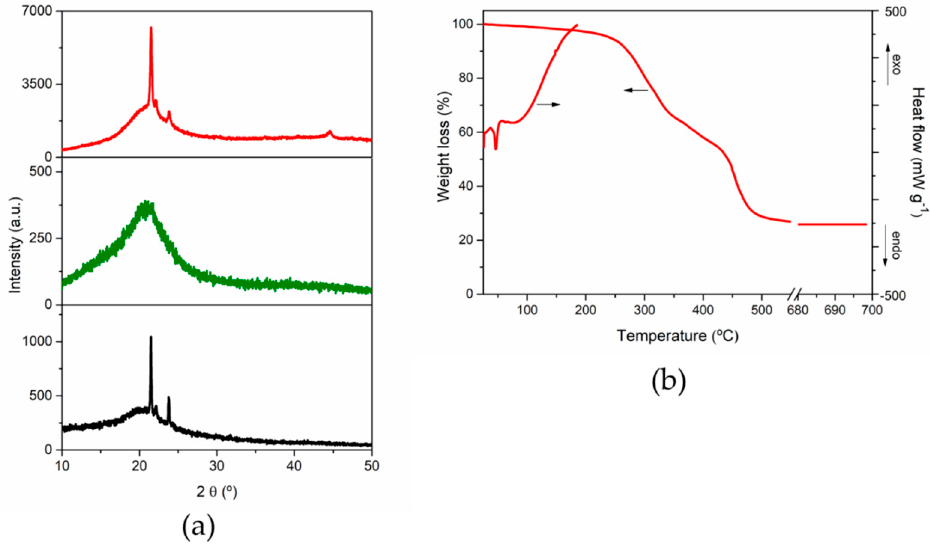
Figure 3. ( a ) Commercial PCL(530) (black line) [27], d-PCL(530)/siloxane [27] (green line), and d- PCL(530)/siloxane 9.1 LiTrif-[Er(tta) 3 (H 2 O) 2 ] (red line); ( b ) TGA (left y-axis) and DSC (right